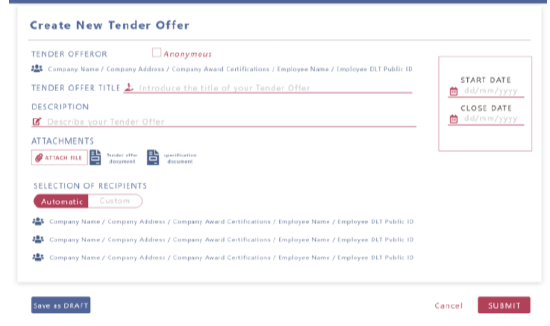
Figure A3. Creation of a new tender offer